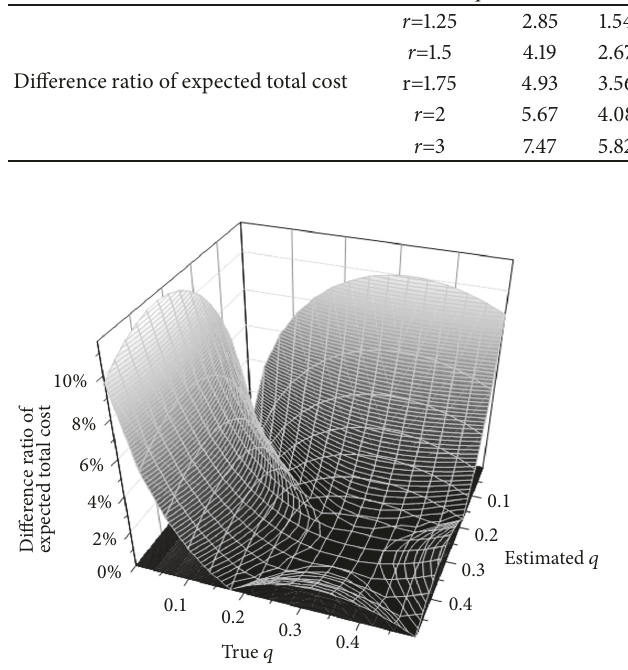
Figure 7: The misestimation of disruption probability q and the difference ratio of expected total